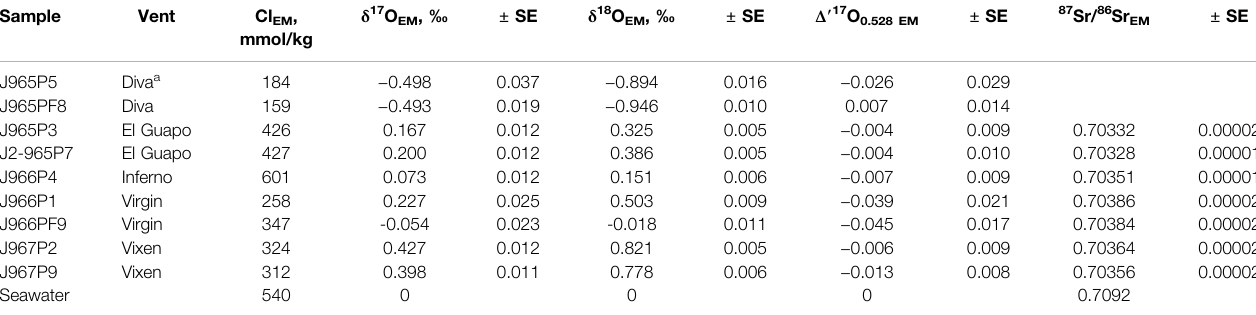
TABLE 3 | Endmember (EM) Cl concentrations along with the endmember triple oxygen and strontium isotope values of hydrothermal fl uids.